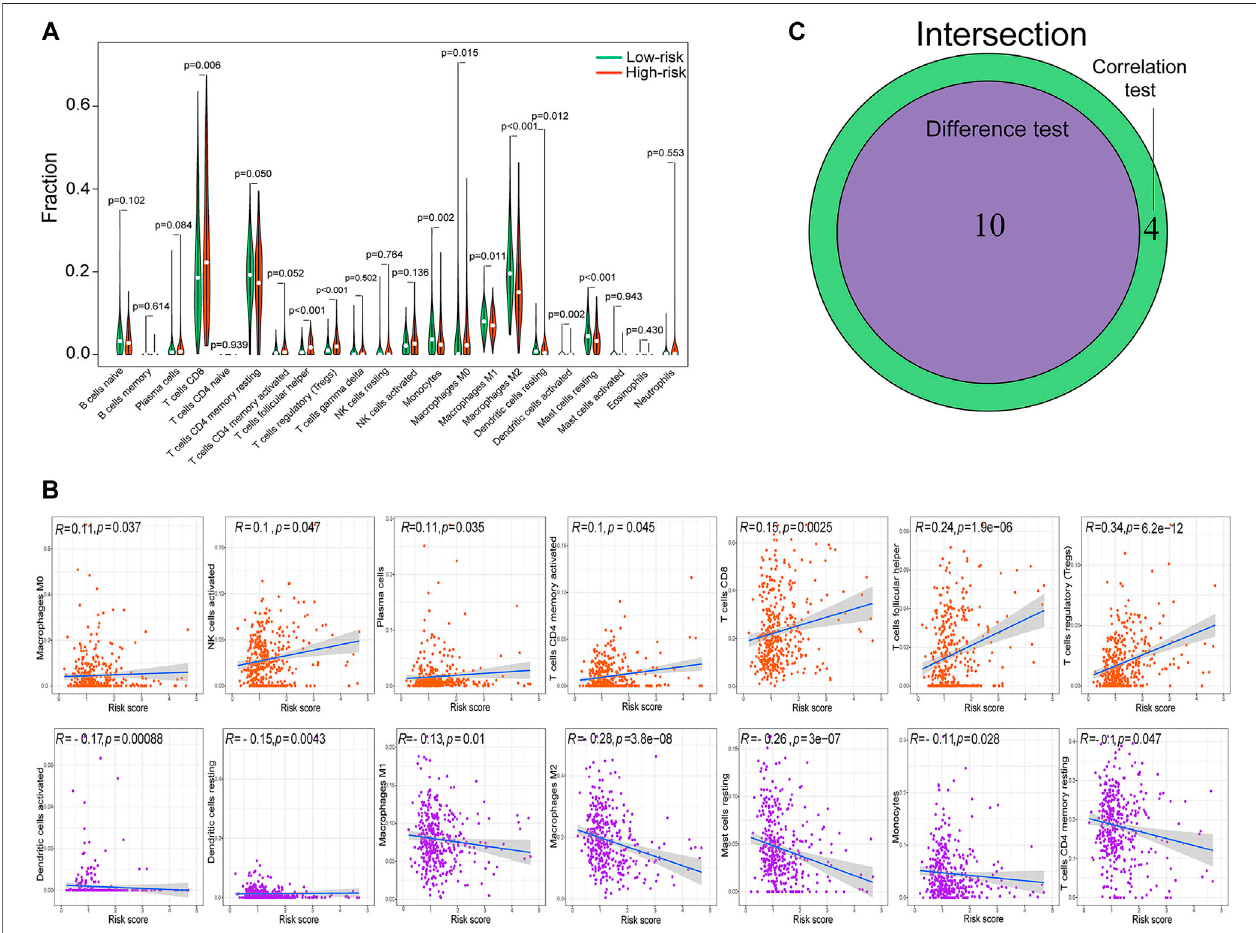
FIGURE 10 | The m6A-RLPS is signi fi cantly associated with tumor-in fi ltrating immune cells (TICs). (A) Violin plots of the difference analysis con fi rming 10 types of TICs, including activated dendritic cells, resting dendritic cells, resting mast cells, M0, M1, and M2 macrophages, monocytes, CD8 T cells, follicular helper T cells, and Tregs, all p < 0.05. (B) Correlation analysis determined 14 types of TICs. (C) Venn diagram of common